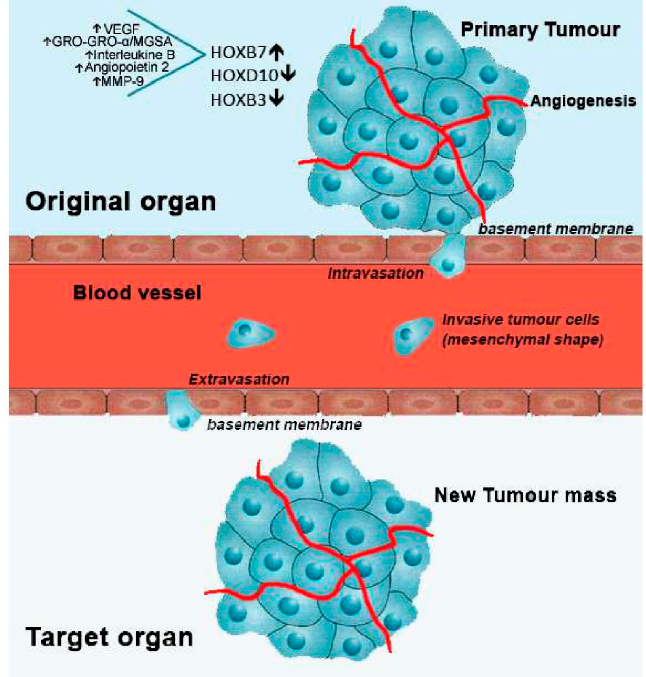
Figure 1. Metastatic process and involved HOX genes, regarding breast cancer. After cell transforma- tion, a mass is rapidly formed in a specific organ of the body, designated as primary tumour.